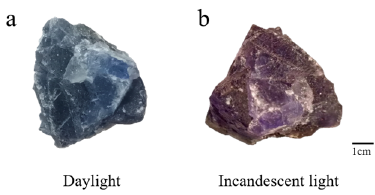
Figure 3. Photographs of color-changing fluorite DBP-1 ( a ) in daylight; ( b ) in incandescent light.